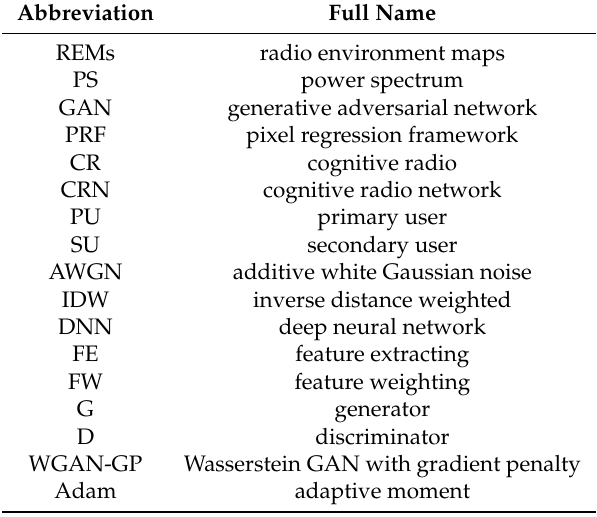
Table 1. The list of